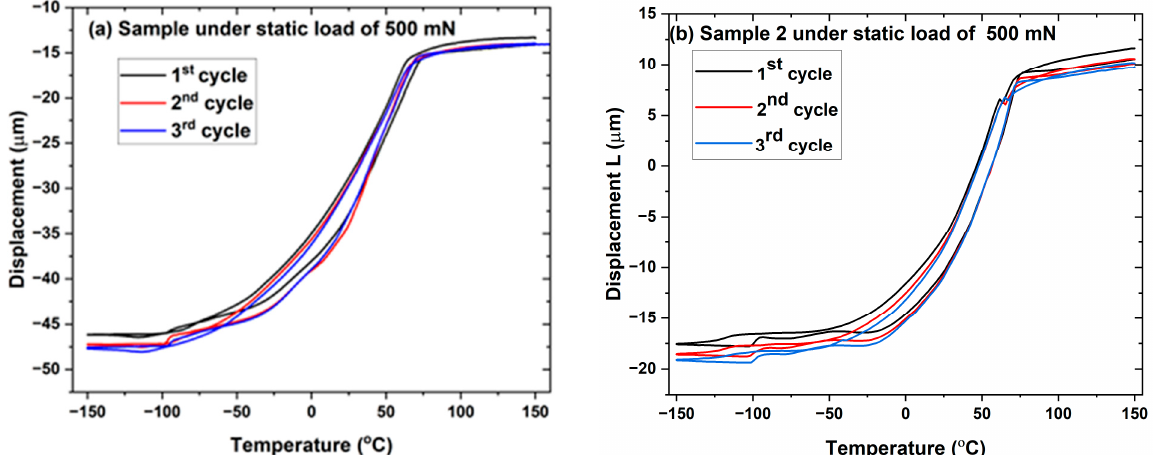
Figure 3. ( a , b ) Samples 1 and 2 under a static load of 500 mN as displacement with temperature. (Due to the limitation of the cooling Dewar, three consecutive experiments could run